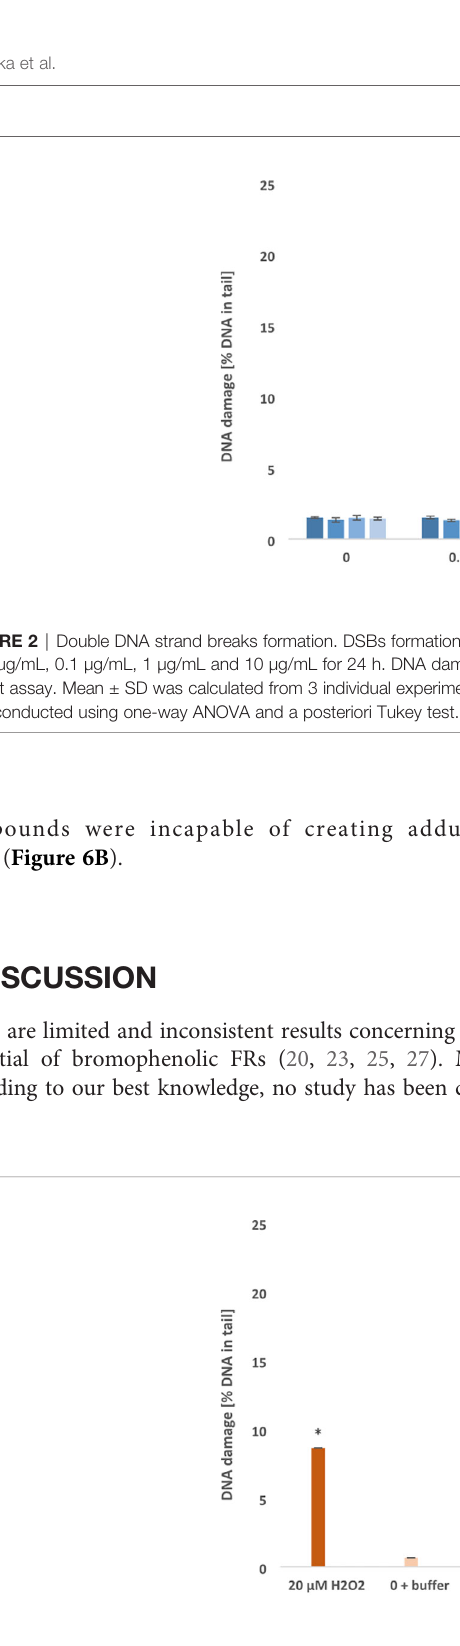
FIGURE 3 | Oxidative damage to pyrimidines in DNA. Oxidative damage to DNA pyrimidines in human PBMCs treated with TBBPA, TBBPS, 2,4,6-TBP and PBP at the concentrations of 0.01 µg/mL, 0.1 µg/mL and 1 µg/mL for 24 h. DNA damage was measured as the percentage of DNA in the comet tail using the enzyme endo III and the alkaline version of the comet assay. The mean ± SD was calculated for 3 experiments (3 blood donors). Statistically different from negative control at *P<0.05. Statistical analysis was conducted using one-way ANOVA and a posteriori Tukey test.